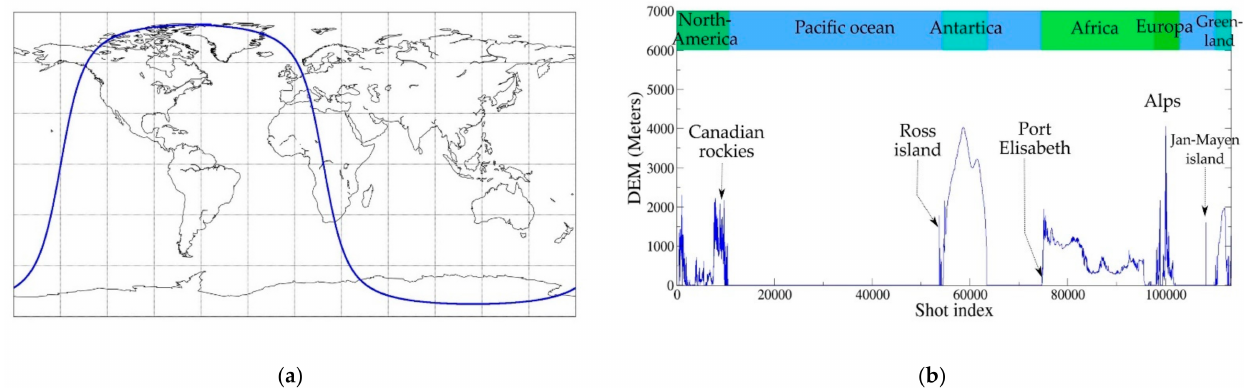
Figure 22. ( a ) Ground track for the orbit used. ( b ) DEM at the MERLIN targets along this